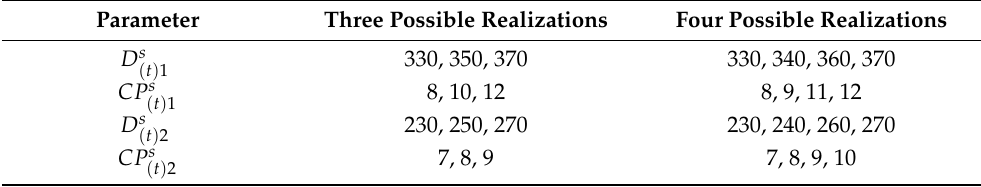
Table 4. Input data for the stochastic programming model: demand and production